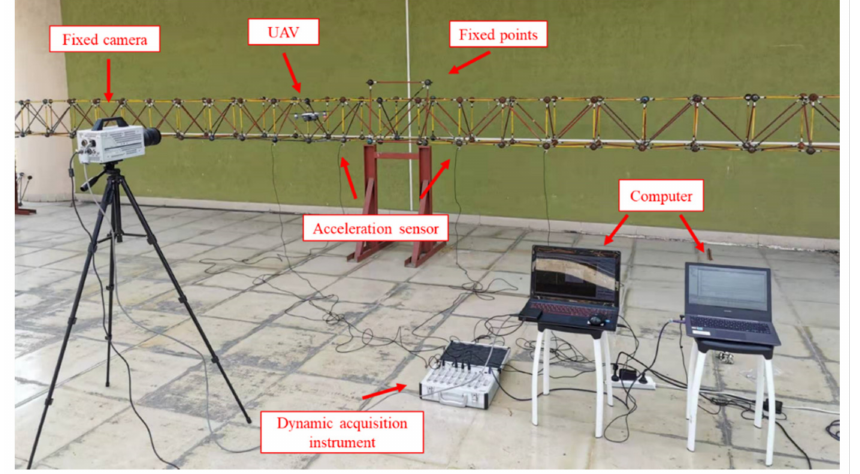
Figure 6. Experimental layout.